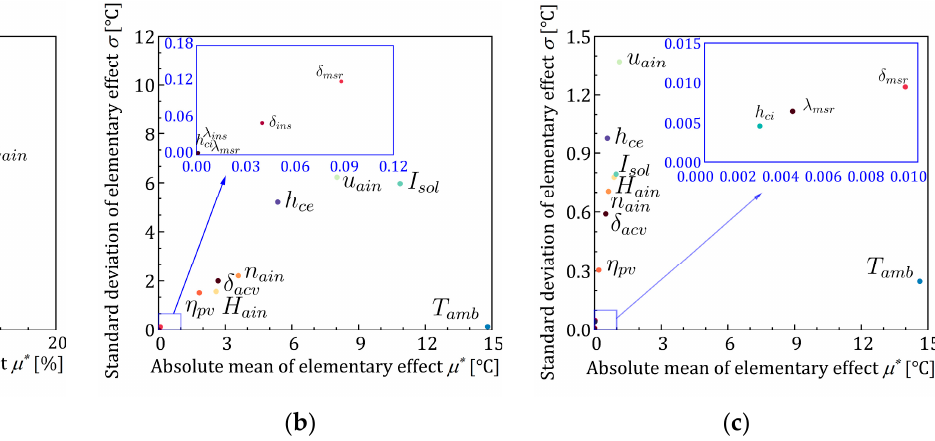
Figure 5. Absolute mean and standard deviation for each input parameter in global screening: ( a ) AUI; ( b ) TPV; ( c ) TAO. ( a ) AUI; ( b ) TPV; ( c )